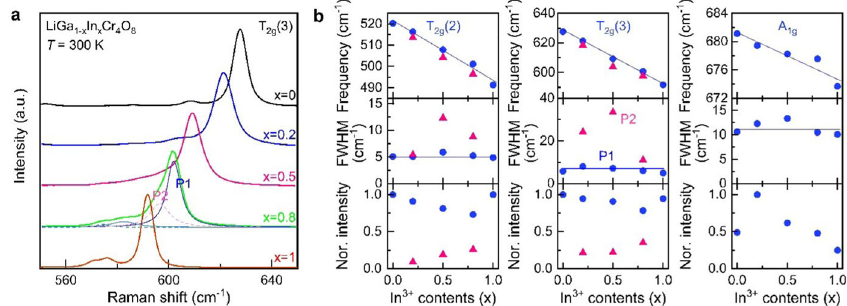
Fig. 5 Composition evolution of high-energy phonons for LiGa 1- x In x Cr 4 O 8 . a Magni fi ed view of the T 2g (3) phonon mode as a function of x . b Composition dependence of the phonon parameters for the T 2g (2), T 2g (3), and A 1g